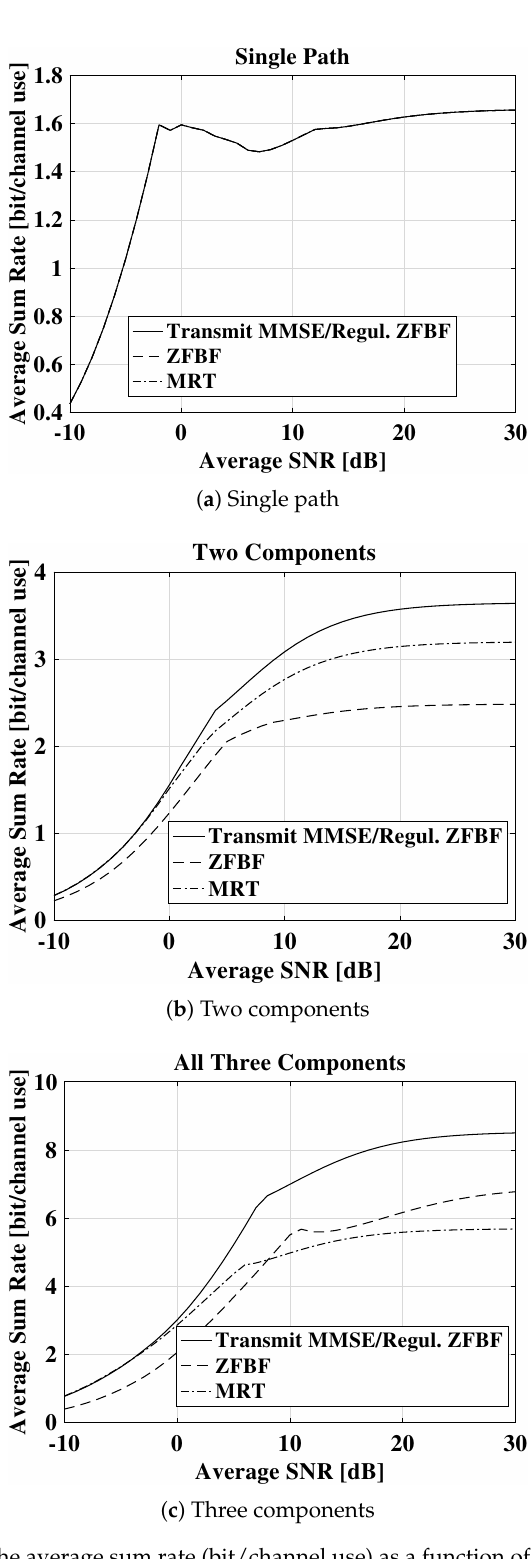
Figure 4. UG MIMO: The average sum rate (bit/channel use) as a function of change in average SNR. ( a ) Single path; ( b ) two components; ( c ) three